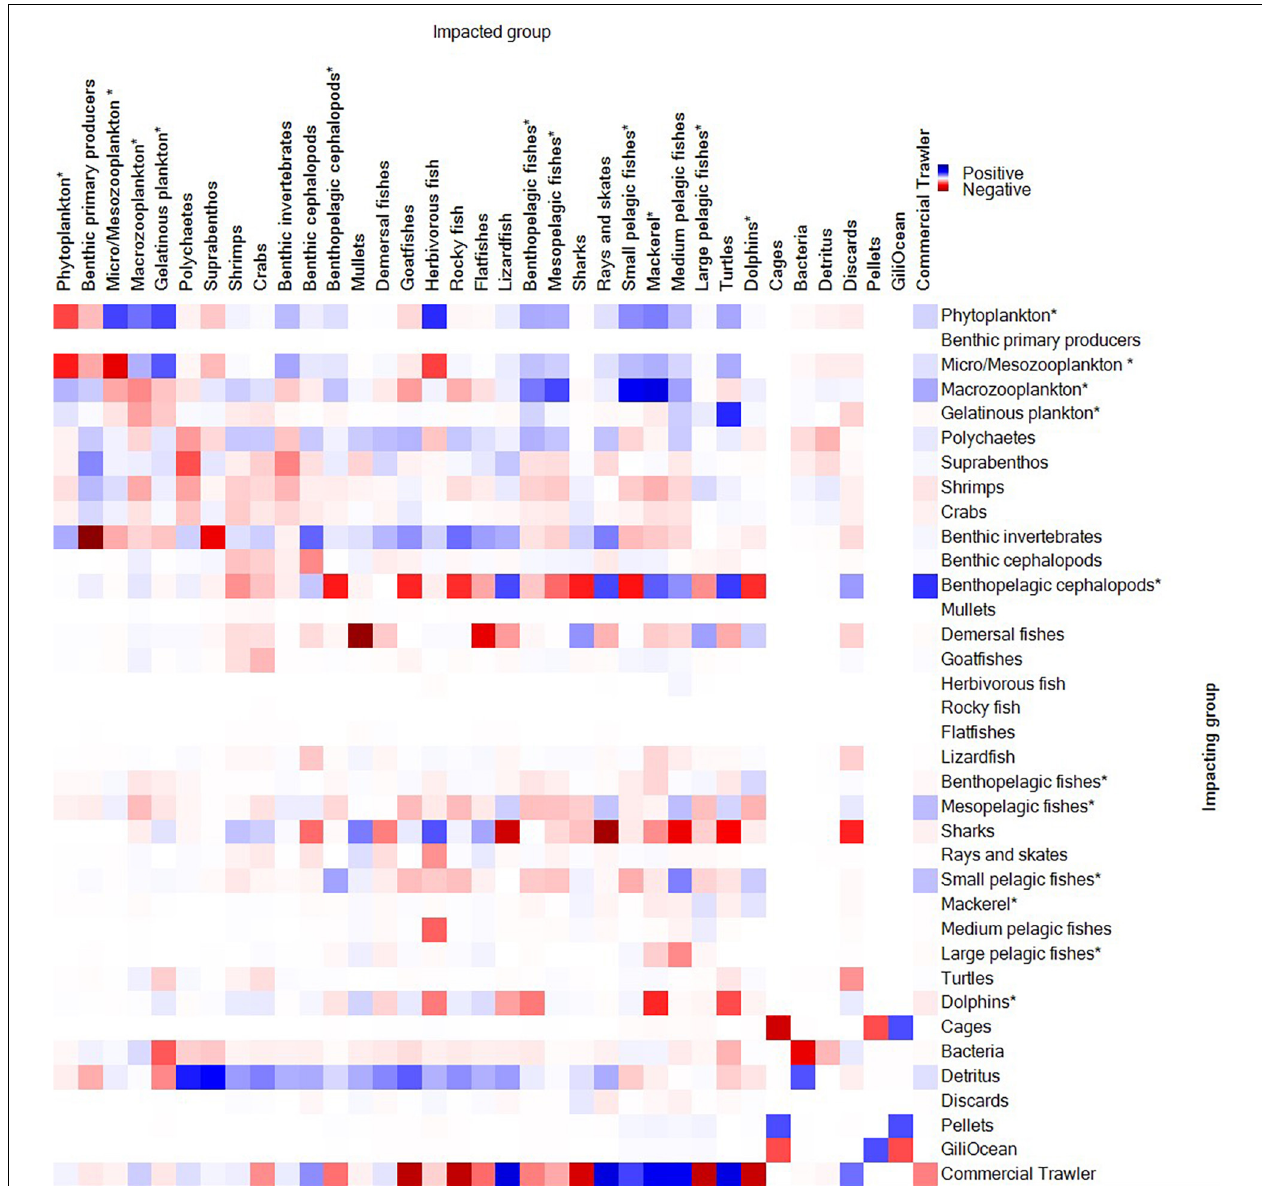
FIGURE 2 | Output of Mixed Trophic Impact analysis of selected functional groups (impacting vs. impacted). Positive impacts are indicated as blue, and negative impacts are indicated by red